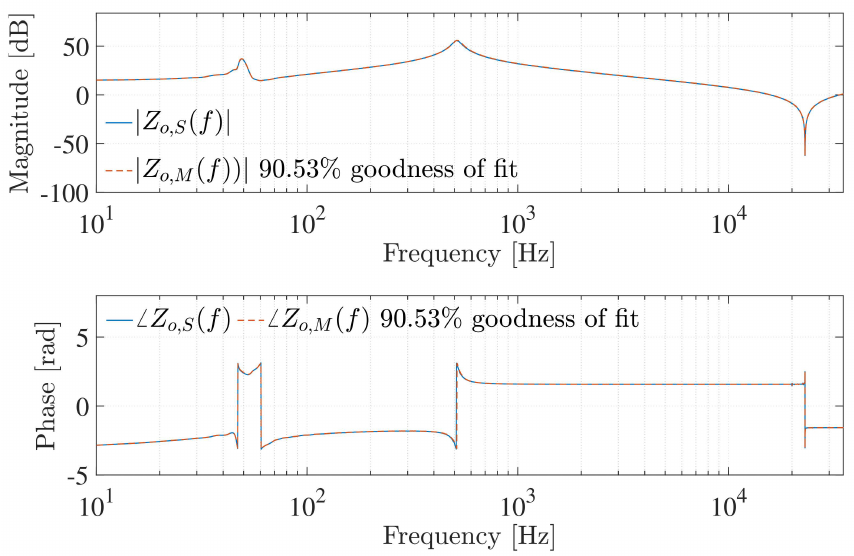
Figure 9. Comparison of the magnitude and phase response of the output impedance of the model after parameter estimation is performed, Z o , M ( f ) , and the target system Z o , S ( f ) .